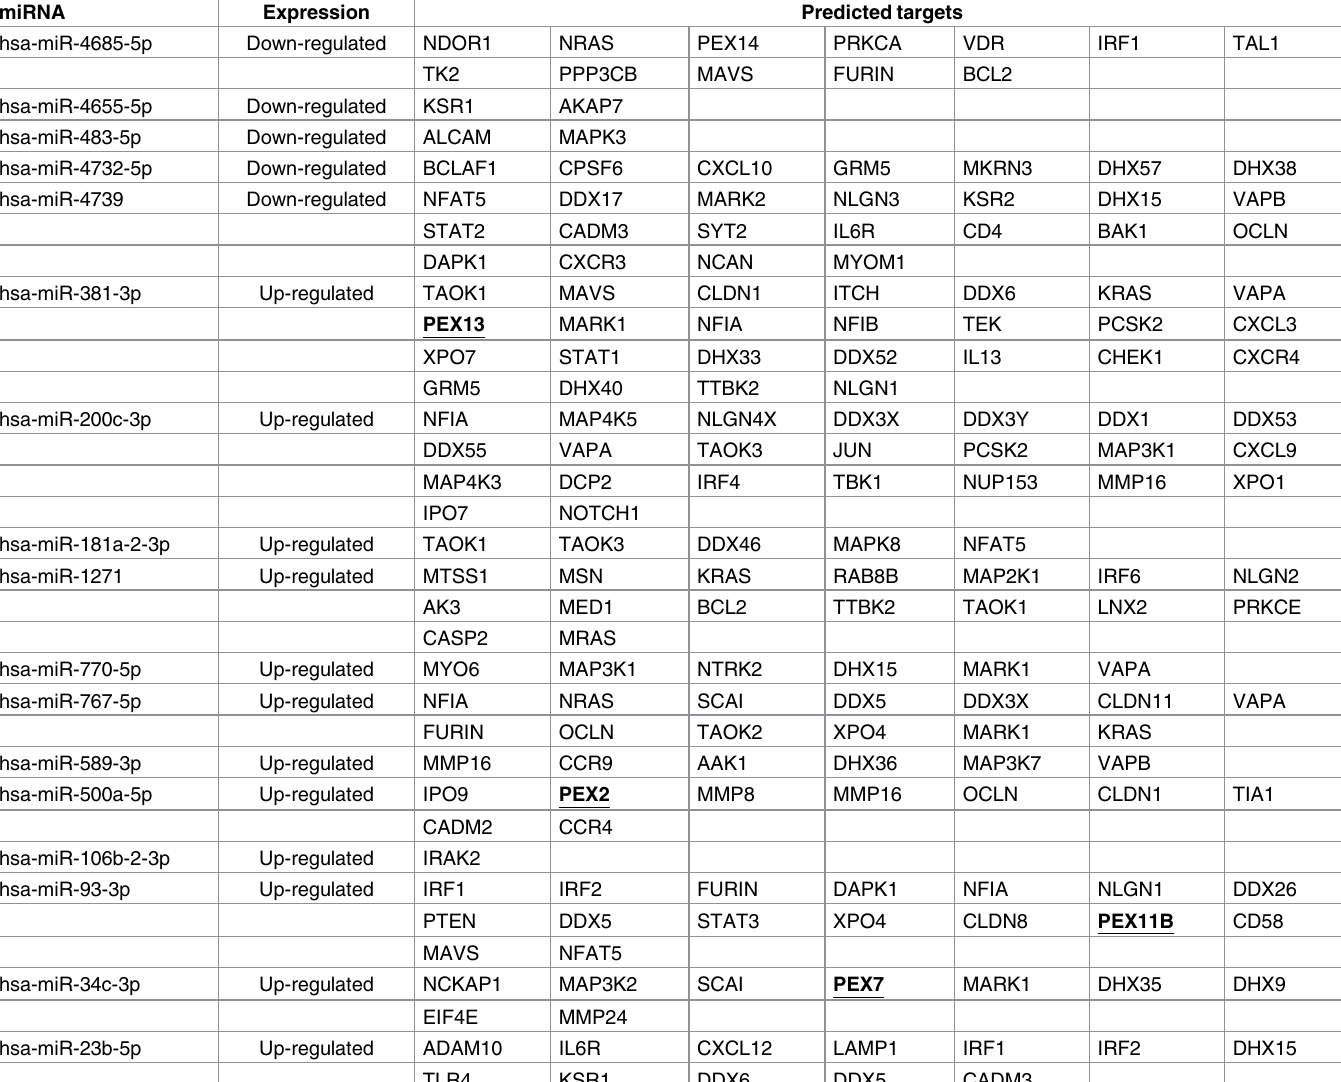
Table 1. Potential targets of miRNAs differentially expressedin HAND brain